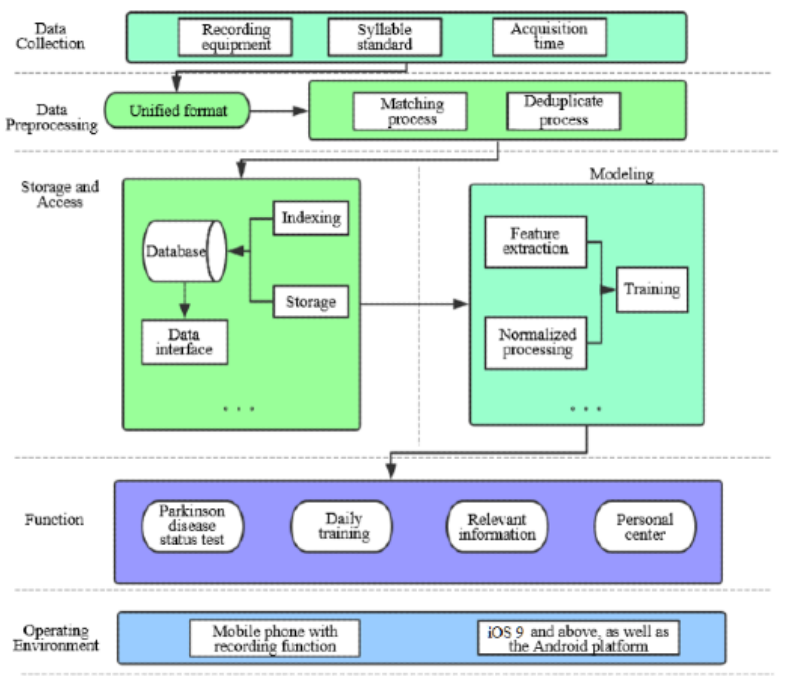
Figure 6. Architecture overview of the No Pa app